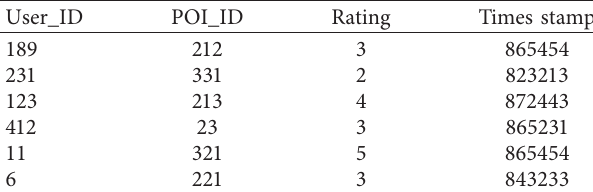
Table 2: User-attraction rating scale.